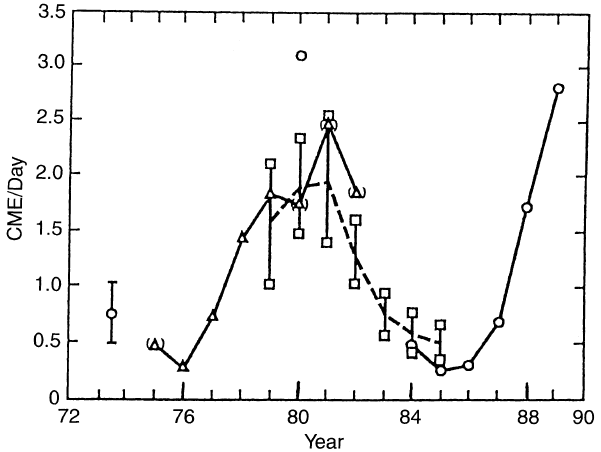
Fig. 2. Rate of occurrence of CMEs over the solar cycle from 1973 to 1989. The data correspond to coronagraphs on Skylab and SMM ( circles ), and P78-1 ( squares ) satellites, and to the Helios 1 and 2 photometers ( triangles ). Two Solwind (P78-1) rates are given, one for all CMEs and a lower one for only ‘‘major’’ CMEs (from Webb and Howard, 1994)